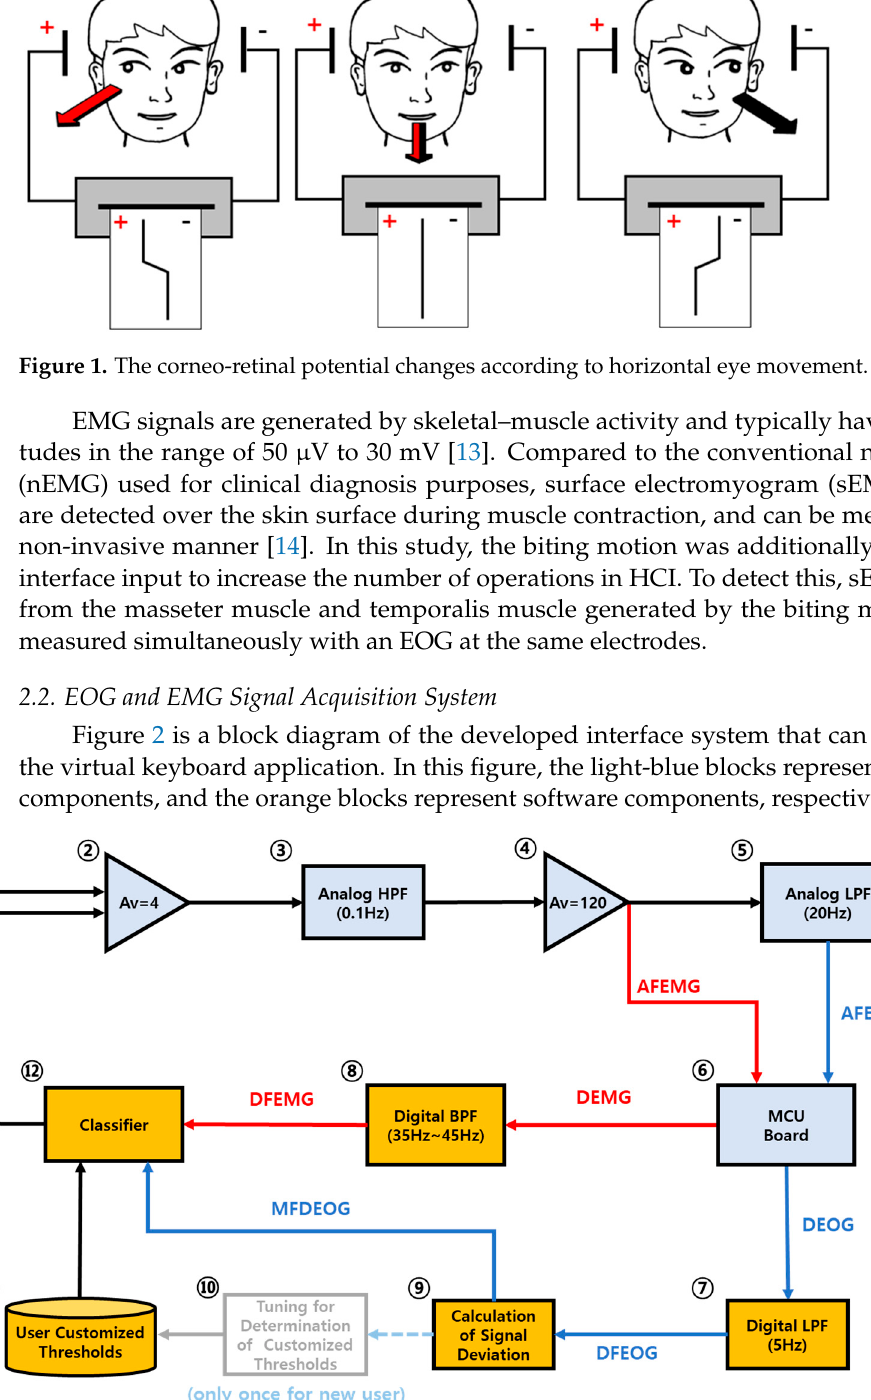
Figure 2. Block diagram of EOG and EMG-based interface system.